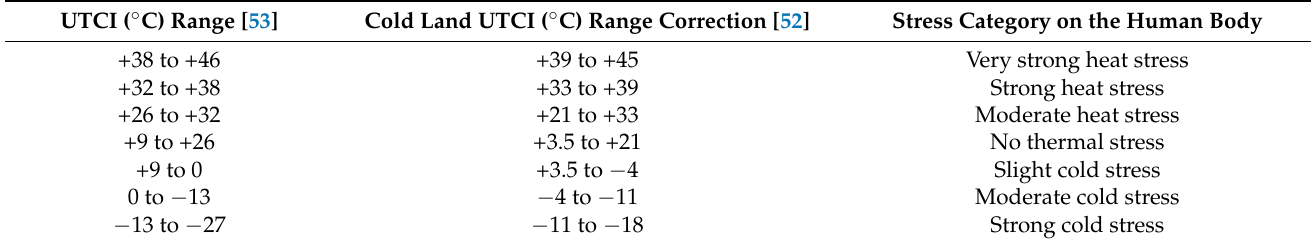
Table 3. UTCI original standard and cold region modified